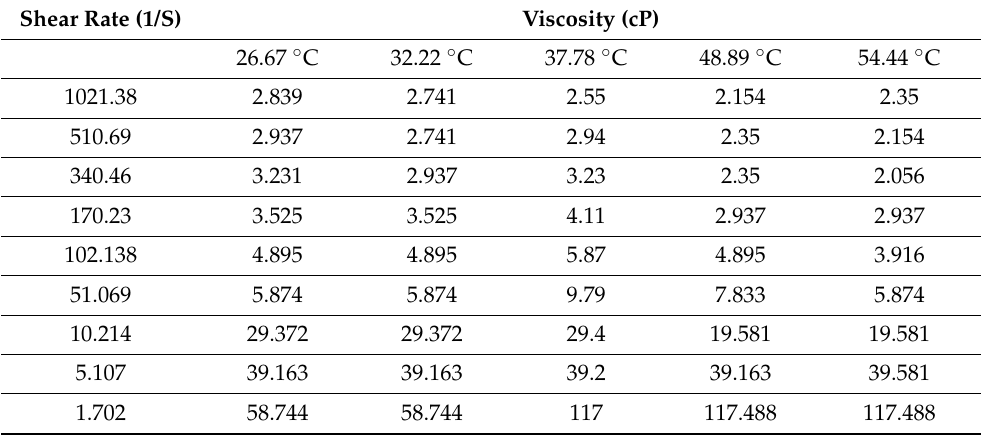
Table 3. Observed and Measured Data for Butanone (0.6%), APG (0.5%), and Xanthan Gum at Various Temperatures.